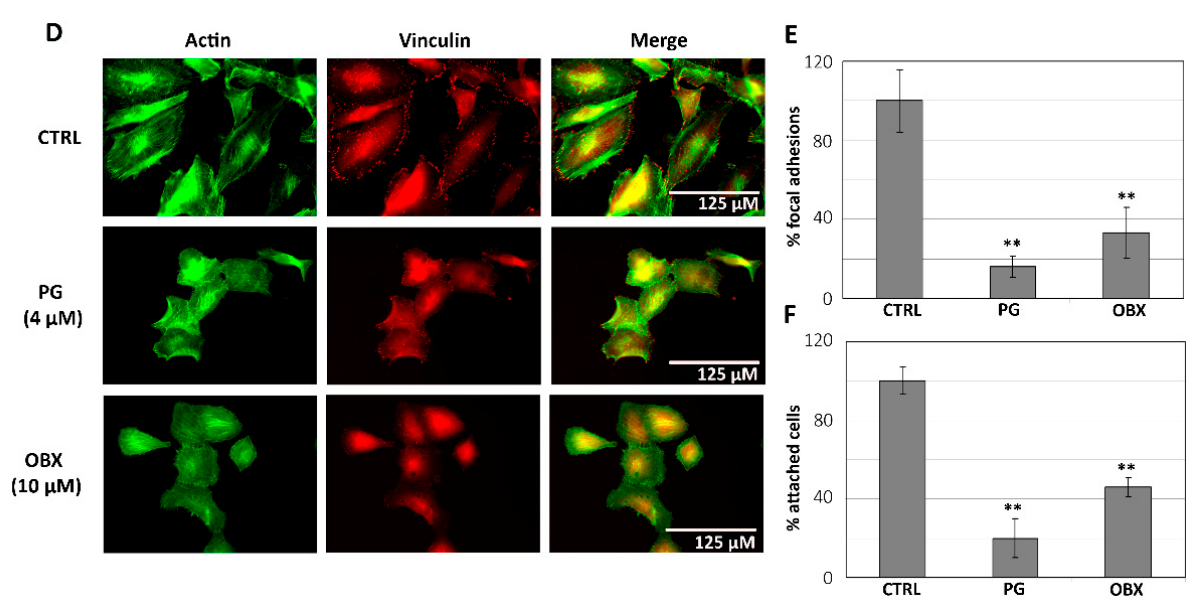
Figure 2. Focal-adhesion evaluation after PG or OBX treatment in SK-MEL-5 ( A – C ) and in SK-MEL-28 ( D – F ). Immunofluorescence of vinculin (red) and actin (green) shows focal adhesions in SK-MEL-5 ( A ) and SK-MEL-28 ( D ) cells after 3 h of treatment with PG (1 or 4 µ M, respectively) or OBX (10 µ M). The percentage of focal adhesions ( B , E ), as well as the percentage of cell attachment ( C , F ), were quantified. Figure shows mean ± SD. Statistical differences from control (CTRL) are shown as ** p < 0.01 and * p < 0.05.